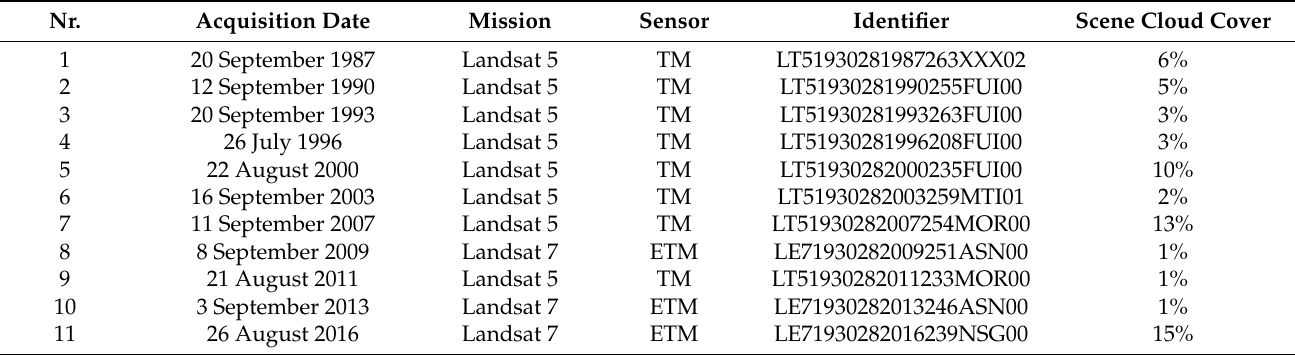
Table 1. List of the eleven Landsat images composing the thirty-years time series. Details about images are provided in the table.